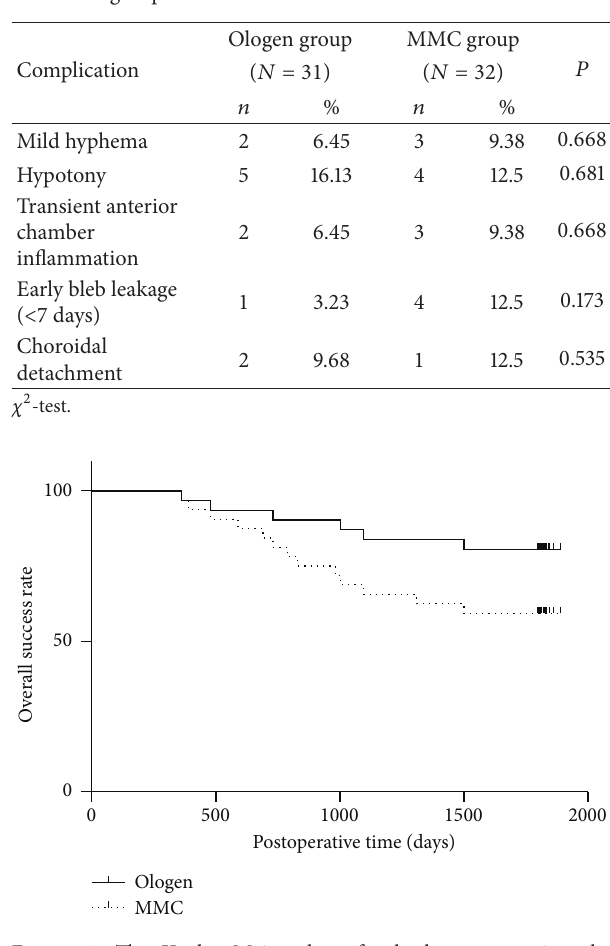
Figure 1: The Kaplan-Meier chart for both groups using the definition of overall success. The differences of the survival curves between both groups were statistically significant.